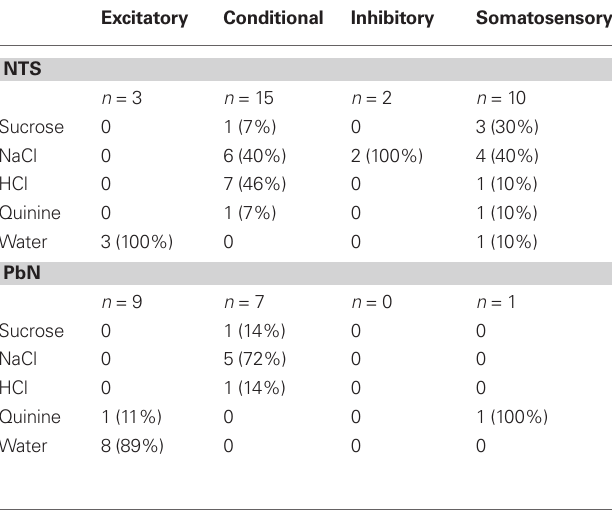
Table 2 | Prevalence of the “best stimulus” for each cell type in the NTS and PbN.